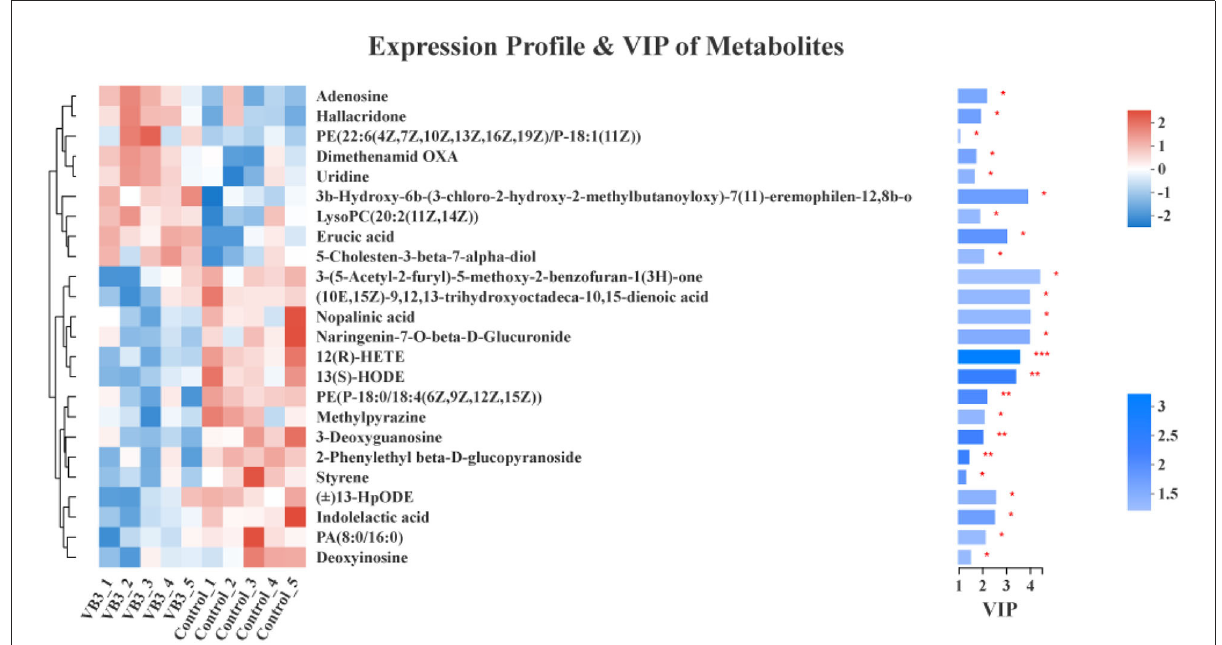
FIGURE5 Differential metabolite cluster dendrogram between the experimental group (VB3) and control group (Control) and variable importance in projection (VIP) of metabolites between the experimental group (VB3) and control group (Control). * P < 0.05; ** P < 0.01; *** P <